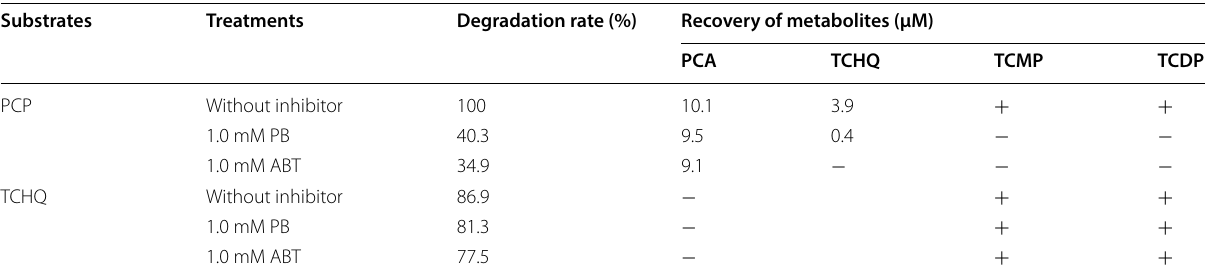
Table 5 Effect of Cyt P450 inhibitors on PCP and TCHQ degradation in LN medium by P. acanthocystis at 10 days